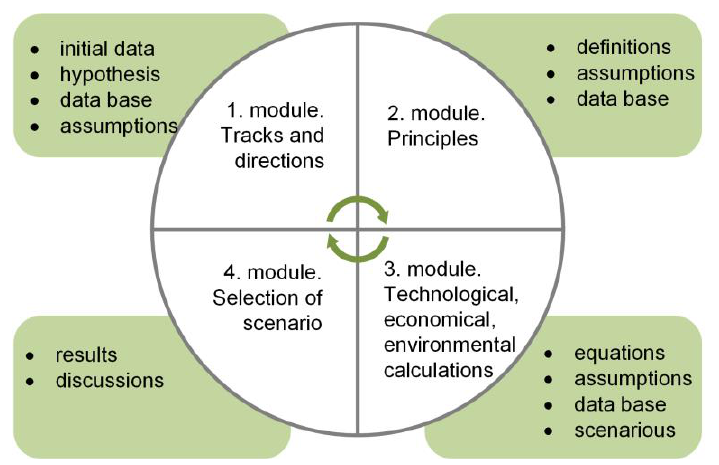
Fig. 3. Algorithm of four-step management